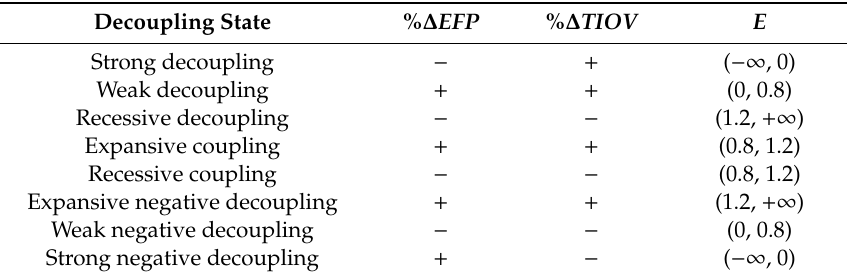
Table 1. Tapio decoupling model division method.